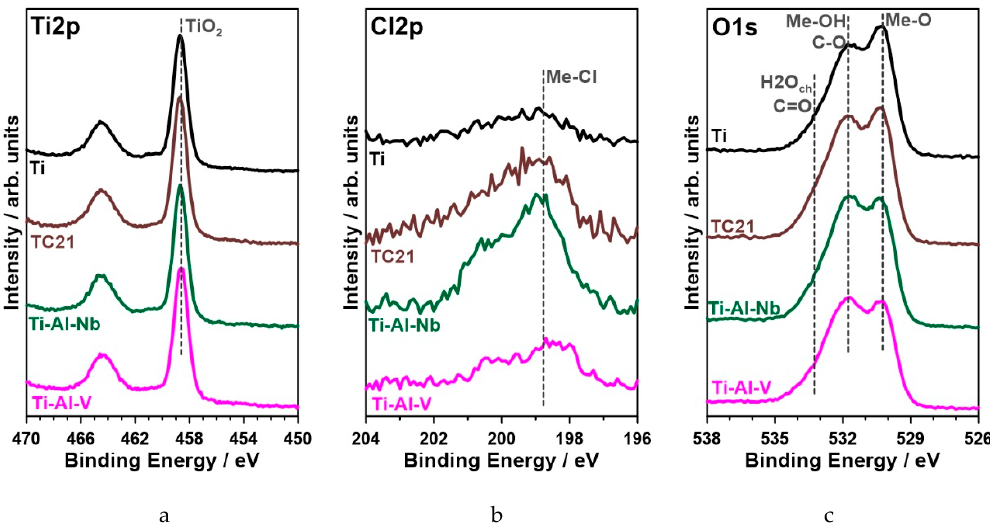
Figure 11. High-resolution XPS spectra recorded in ( a ) Ti 2p , ( b ) Cl 2p and ( c ) O 1s energy range for each investigated alloy after seven days of exposure to 0.9% NaCl solution at 37 °C. investigated alloy after seven days of exposure to 0.9% NaCl solution at 37 ◦